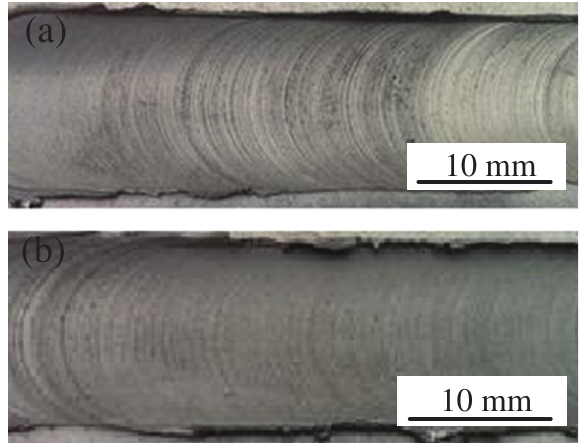
Figure 4: Surface morphology of joints under different widths of 2024-T4 alloy as compensation strip: (a) 1 mm and (b) 1.5 mm.